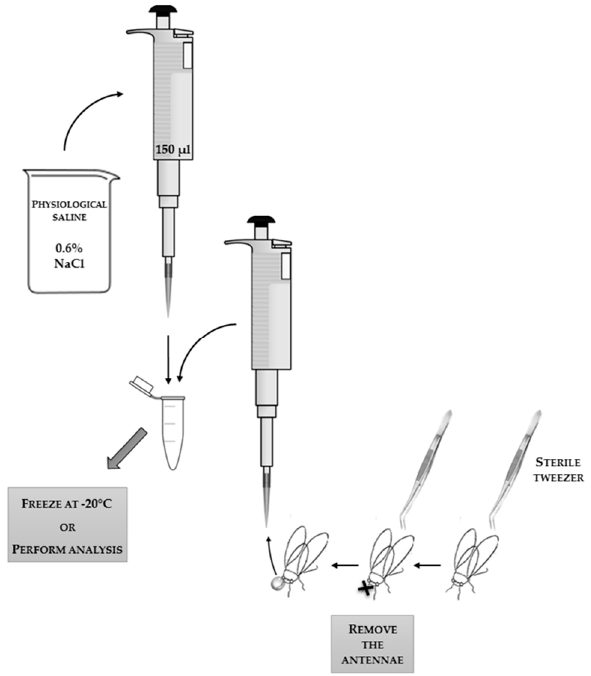
Figure 1. The scheme of the technique of collecting hemolymph flowing out of the insect’s head after detachment of the antennae. The applied tools and reagents, along with the used volumes, are presented in the scheme.